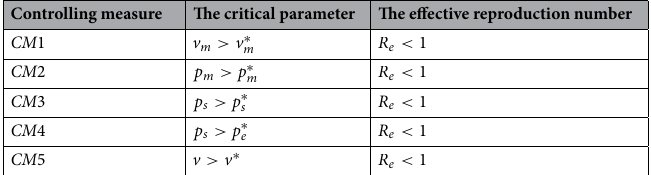
Table 3. The threshold value of the effective reproduction number is smaller than one.